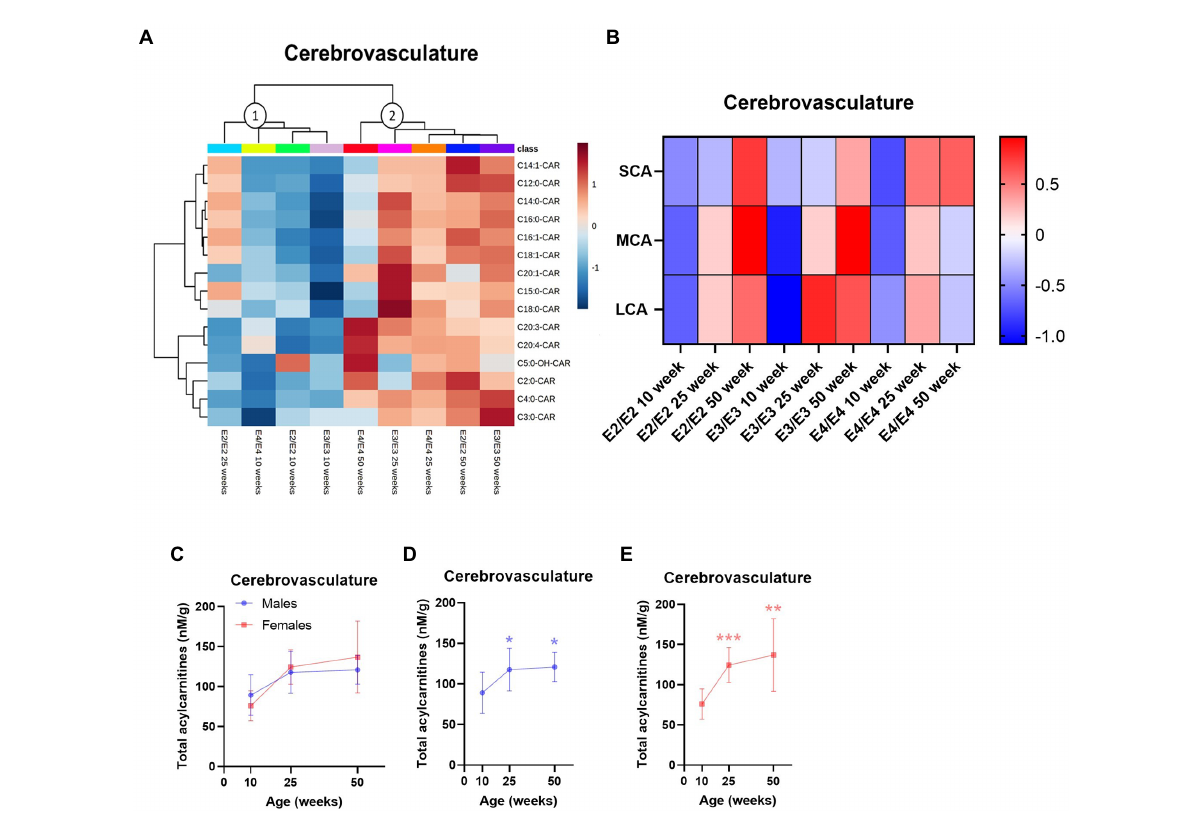
FIGURE 3 Age leads to increases in cerebrovascular acylcarnitines in an APOE- dependent manner. (A) Hierarchical clustering heatmap showing acylcarnitine species with APOE genotypes at different age timepoints in the cerebrovasculature. (B) Z-score heatmap showing acylcarnitine chain length ratios to total acylcarnitines with APOE genotypes at different age timepoints in the cerebrovasculature. (C) Line graphs showing mean ± SD total acylcarnitines in nM per gram of protein in males and females at different age timepoints in the cerebrovasculature. (D) Line graphs showing mean ± SD total acylcarnitines in nM per gram of protein in males at different age timepoints in the cerebrovasculature, * comparison with 10 weeks. (E) Line graphs showing mean ± SD total acylcarnitines in nM per gram of protein in females at different age timepoints in the cerebrovasculature, * comparison with 10 weeks. Statistics: For the clustering heatmap data were normalized and scaled before being analyzed using Ward’s clustering, with the top 15 acylcarnitines selected by ANOVA. Multiple comparisons with B-H correction were performed on the data, * p < 0.05, ** p < 0.01, *** p < 0.001. Numbers per group; 10-week APOE2-TR n = 6, 25-week APOE2-TR n = 5, 50-week APOE2-TR n = 6, 10-week APOE3-TR n = 6, 25-week APOE3-TR n = 5, 50-week APOE3-TR n = 6, 10-week APOE4-TR n = 6, 25-week APOE4-TR n = 6, 50-week APOE4-TR n = 4, 10-week (males) n = 9, 25-week (males) n = 8, 50-week (males) n = 9, 10-week (females) n = 9, 25-week (females) n = 8, 50-week (females) n = 7. Cx:y- CAR, acylcarnitines; Cx:y-OH-CAR, hydroxy acylcarnitines; LCA, long chain acylcarnitines; MCA, medium chain acylcarnitines; SCA, short chain